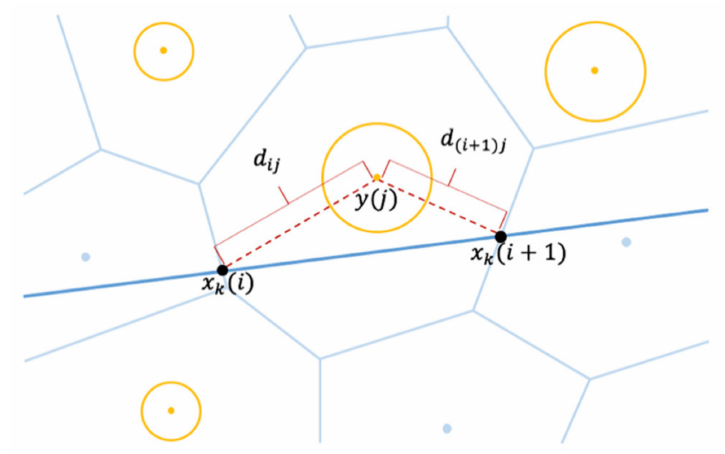
Figure 11. Illustrating graphics showing how distance from the route and visited cell tower is measured using the Voronoi cell-based method.